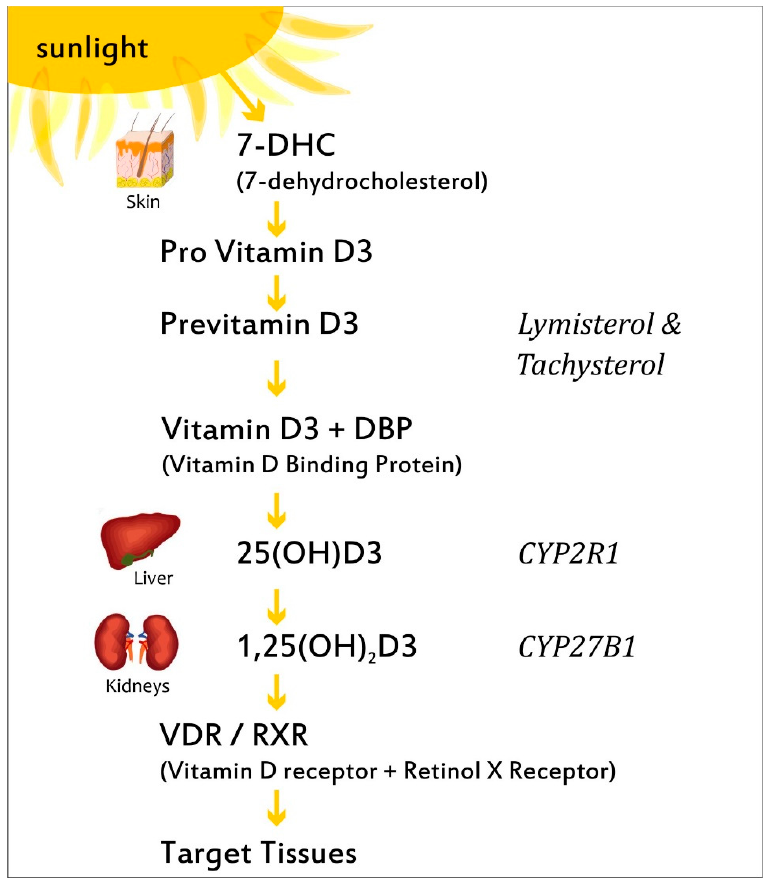
Figure 2. The biosynthesis and metabolism of VitD. Ultraviolet radiation stimulates provitamin D3 to previtamin D3 in the epidermis, which can be either photolyzed to lymisterol and tachysterol or isomerized to VitD3. VitD3 is transported by a binding protein (DBP) to the liver, where it is hydroxylated by CYP2R1 to calcidiol (25(OH)D3). Subsequently, 25(OH)D3 is transported by the DBP to the kidney, where it is hydroxylated in the proximal renal tubule by CYP27B1 (1- α -hydroxylase), resulting in calcitriol, 1,25(OH) 2 D3), the hormonally active form.